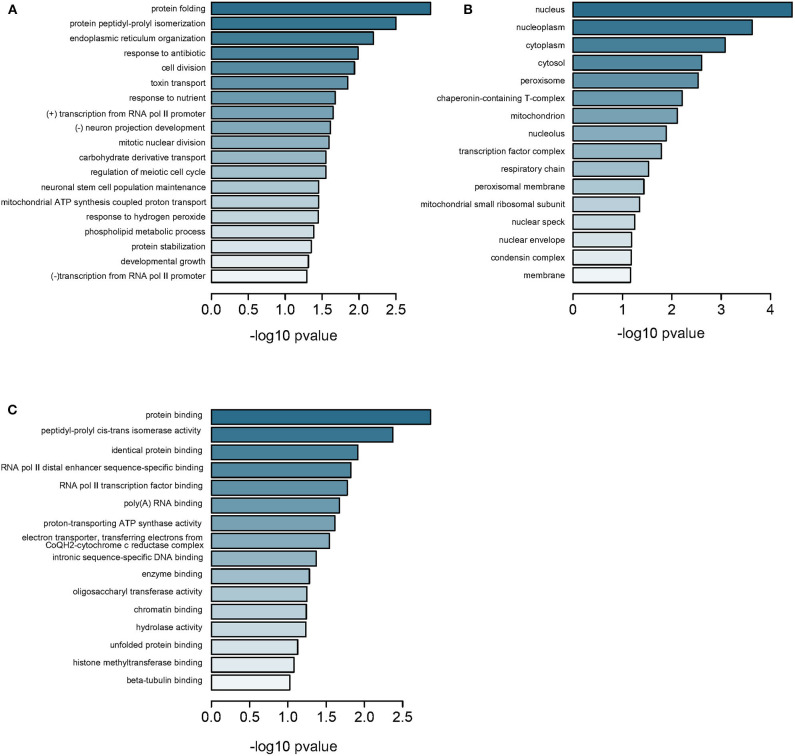
Enrichment analysis of DMGs in all regions. (A) Subontology of biological process (BP). (B) Subontology of cellular components (CC). (C) Subontology of molecular function (MF). (A–C) The x-axis indicates the log p-value. The y-axis is the enriched terms.